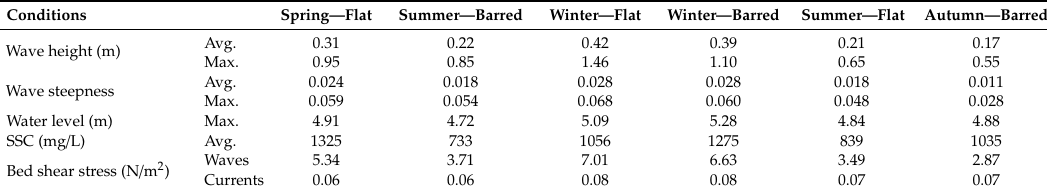
Table 2. Overview of the hydrodynamic conditions and SSC for all campaigns.